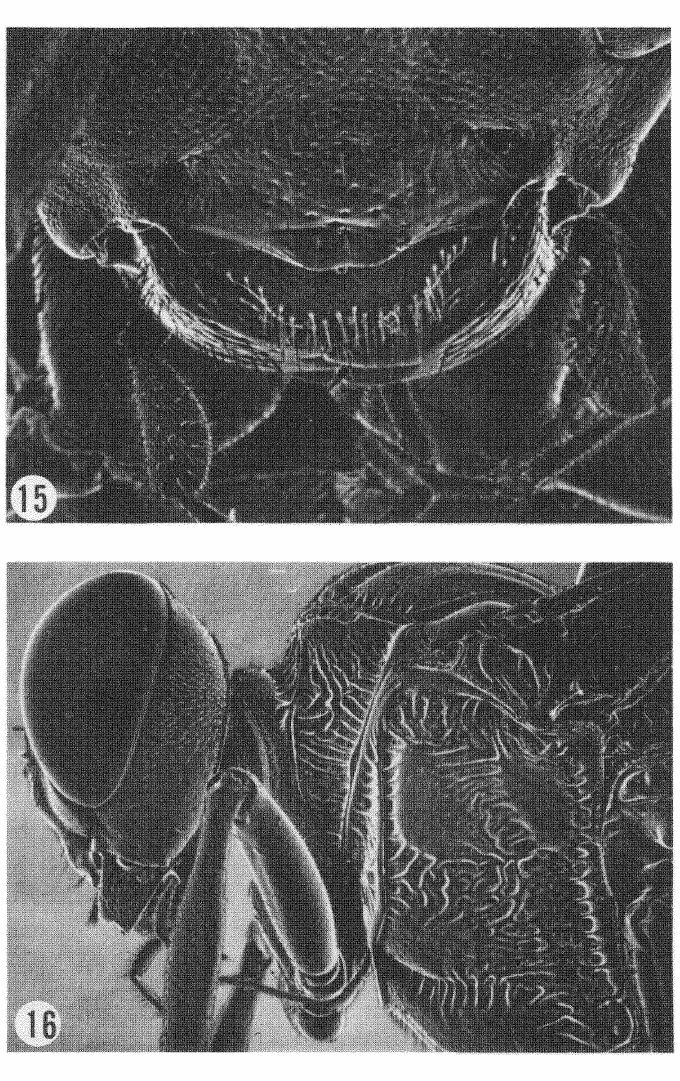
Fig. 15. Cosmiocryptus weyrauchL and adjacent areas in anterior view. Fig. 16. Cosmiocryptus weyrauchL prothorax, and mesothorax in lateral